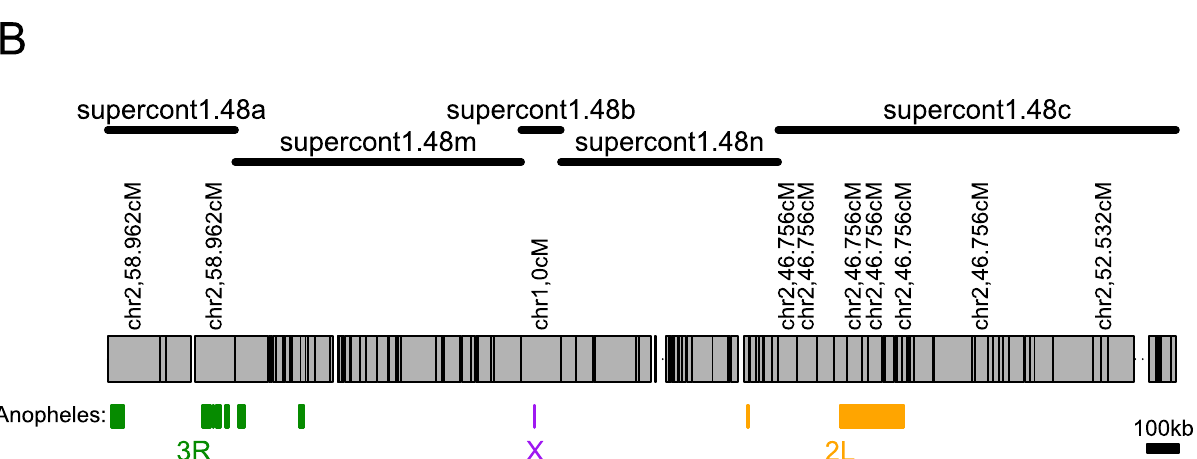
genetic map (Figure 2, Tables 1, S2), including 531 scaffolds that were not included on the most recently published map. The map order is highly consistent with a recently published map that integrated the genetic, physical, and genomic maps of the previous decades [20] (Figure 3; Spearman correlation, Chromosome 1: r =0.803, P =0.0017; Chromosome 2: r =0.899, P =0 , 0.0001; Chromosome 3: r =0.857, P =0.0004). Because of low rates of recombination, the orientations of individual scaffolds and the ordering of scaffolds within centimorgan positions could not be determined. In total, we have placed 807 Mb of genomic sequence onto chromosomal scaffolds, representing 58% of the base pairs in the current genome assembly and 60% of the annotated genes. We were also able to assign an additional 66 scaffolds to chromosomes but not to specific positions. Combined with the previous integrated map, the total number of scaffolds currently assigned to chromo- somes is 691, representing 909 Mb and 66% of the genome.